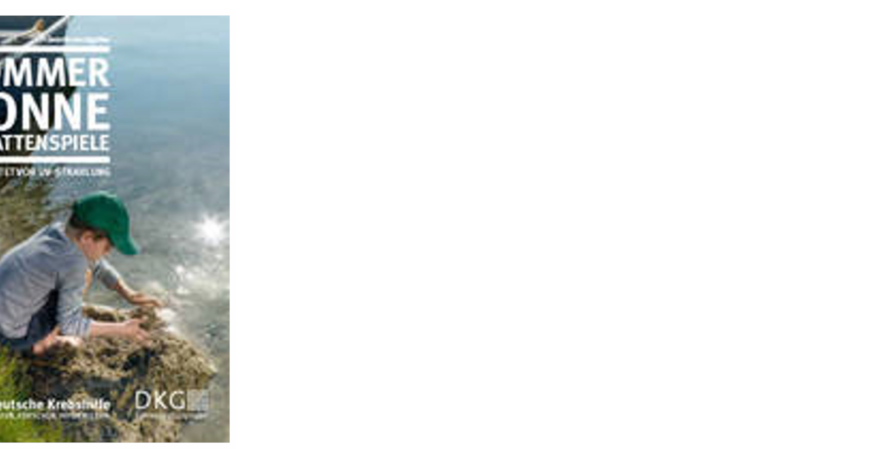
Figure 3. Skin cancer prevention brochure by German Cancer Aid © German Cancer Aid